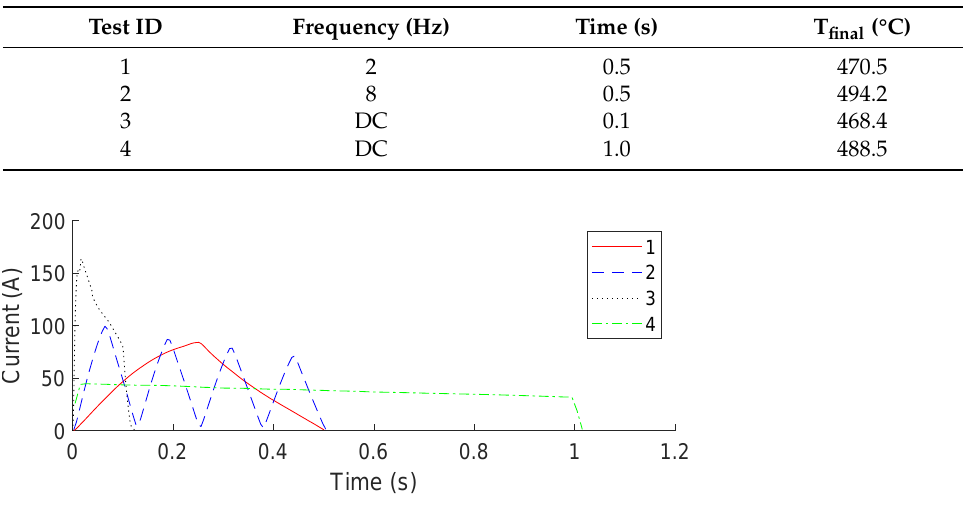
Figure 12. Current profiles for numerical thermal simulation study; Legend values correspond to tests described in Table 2.